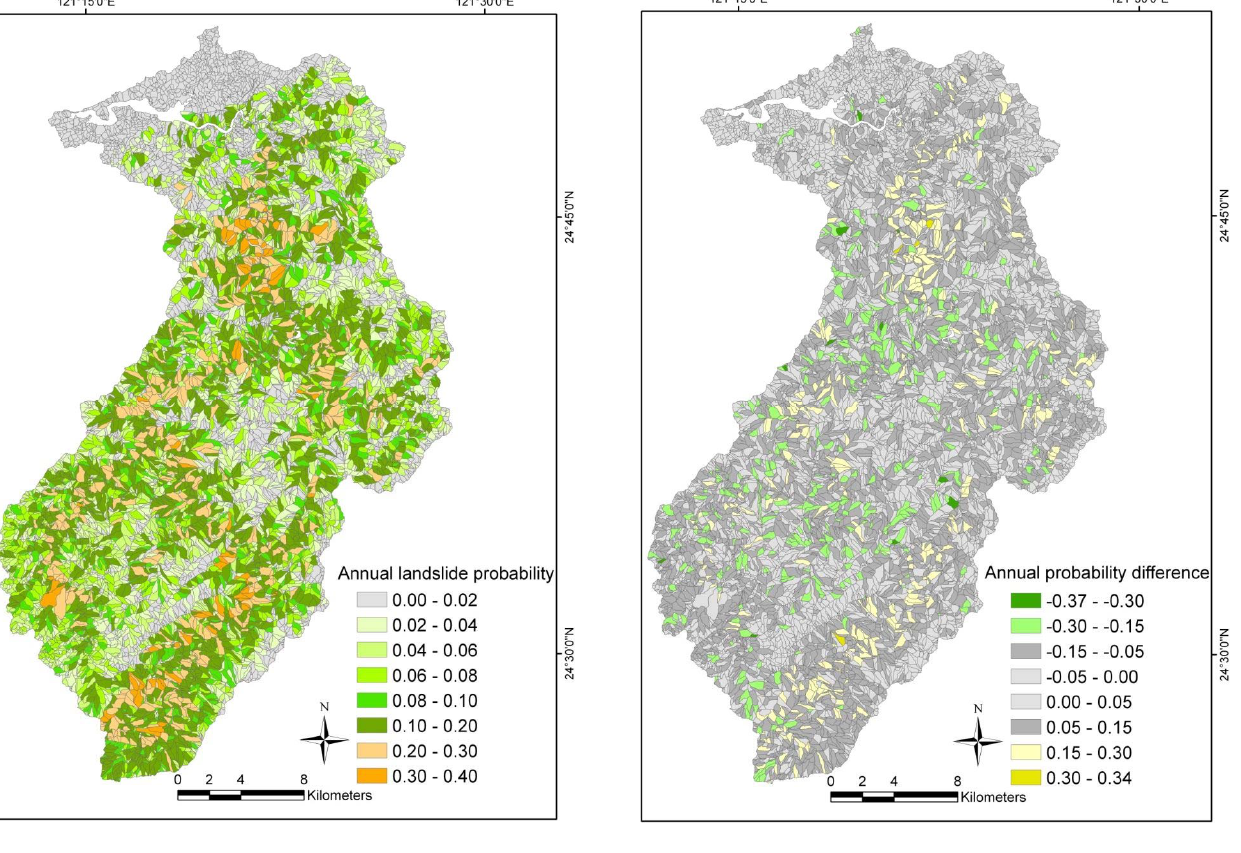
Fig. 11. Annual landslide probability obtained conjugating the re- sults of rainfall events with various recurrence intervals.